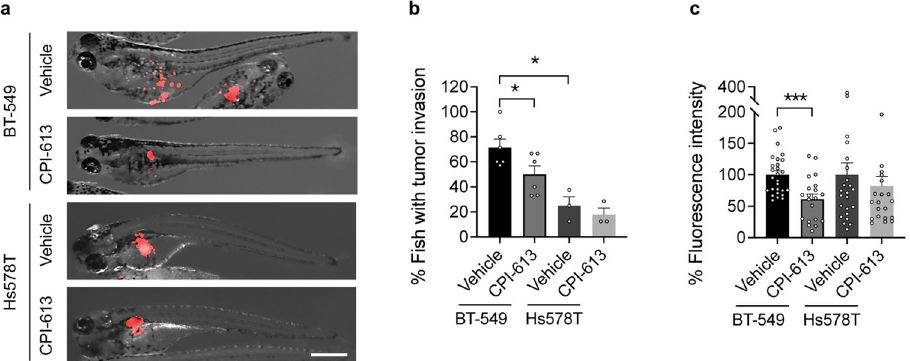
Fig. 8 CPI-613 reduces tumor burden and invasion in zebra fi sh xenografts of DLST-dependent but not independent TNBC cells. a The representative overlay images of bright fi eld and RFP channel of zebra fi sh embryos transplanted with RFP + BT-549 cells at 2 days of post-treatment. b , c Quantitative data indicate the changes of tumor invasion ( b ) and burden ( c ) after the treatment. Tumor cell invasion was determined for the percentage of zebra fi sh xenografts that have tumor cells migrated away from the original injection site in each experimental repeat ( a , b ): n = 3 – 6. Tumor burden was quanti fi ed based on the fl uorescence intensity using ImageJ 1.52a ( a , c ). Fish number for BT-549: n = 27 for vehicle and 20 for CPI-613, respectively; and Hs578T: n = 24 for vehicle and 22 for CPI-613, respectively. Scale bar = 0.5 mm. Statistical difference was calculated using an unpaired two-tailed t -test. * P ≤ 0.05, *** P ≤ 0.001.